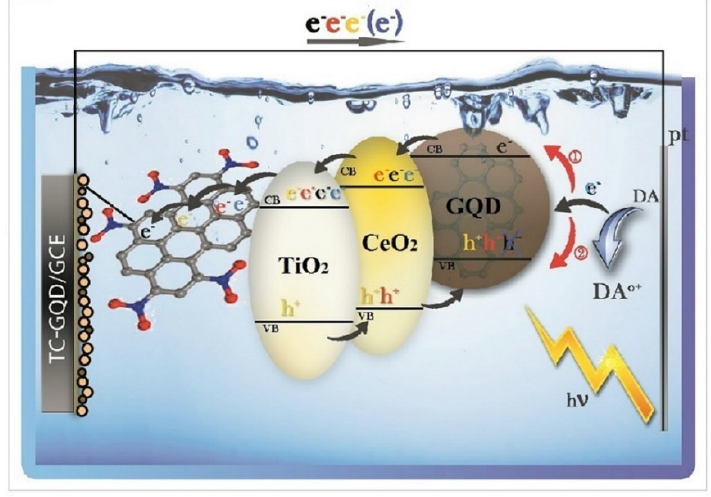
Figure 32. Sensing mechanism of TiO 2 /Ceria/GQD nanocomposites for dopamine detection. Figure 32 reprinted with permission from [157]. Copyright @ 2017 Elsevier.